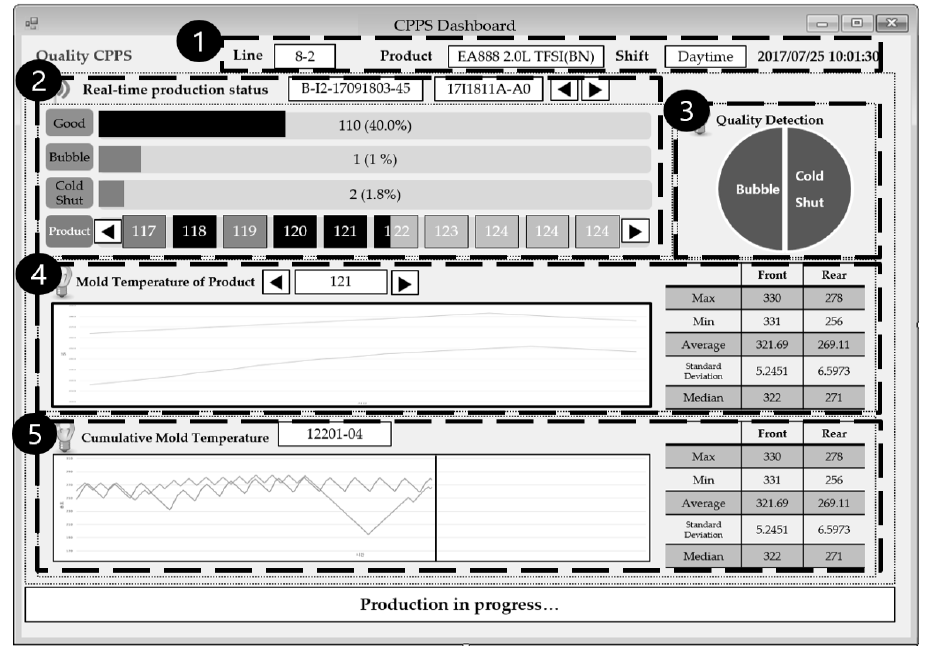
Figure 7. Main screen of the CPPS dashboard. Table 8. Description of each section of the main screen of the dashboard.